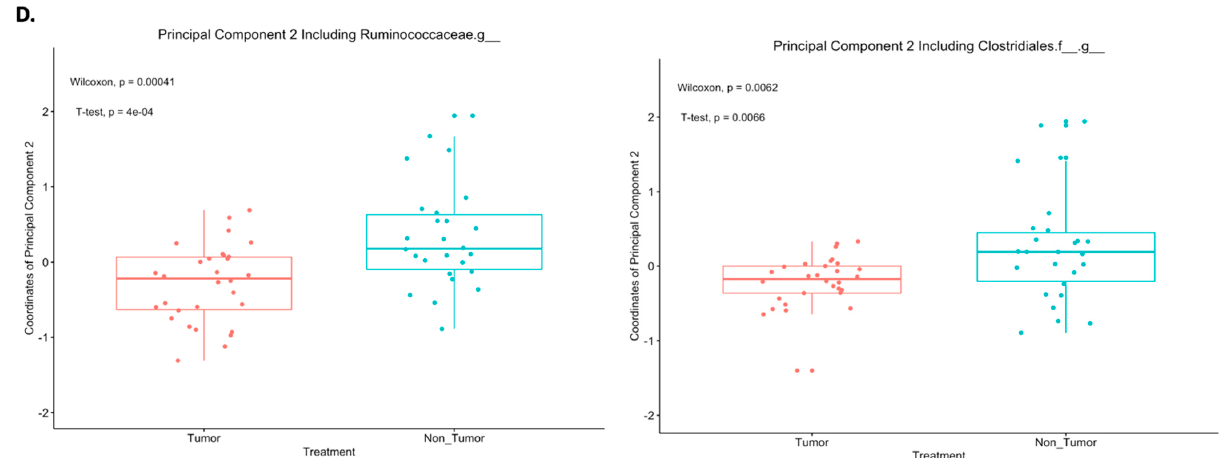
Figure 3. Significant predictors of tumor presence include the second principal components involving Bacteroidales.f__S24.7 , Clostridiales, and Ruminococcaceae . ( A , B ) Using the CORElearn package in the R programming language, the information gains and ReliefF weights were calculated for each taxon.